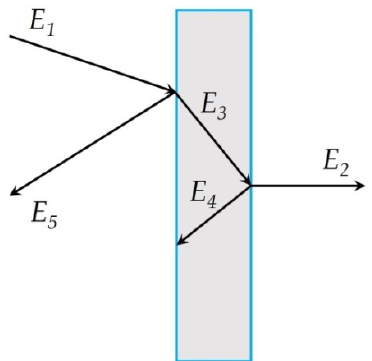
Figure 1. Interaction of an electromagnetic wave with a screen.